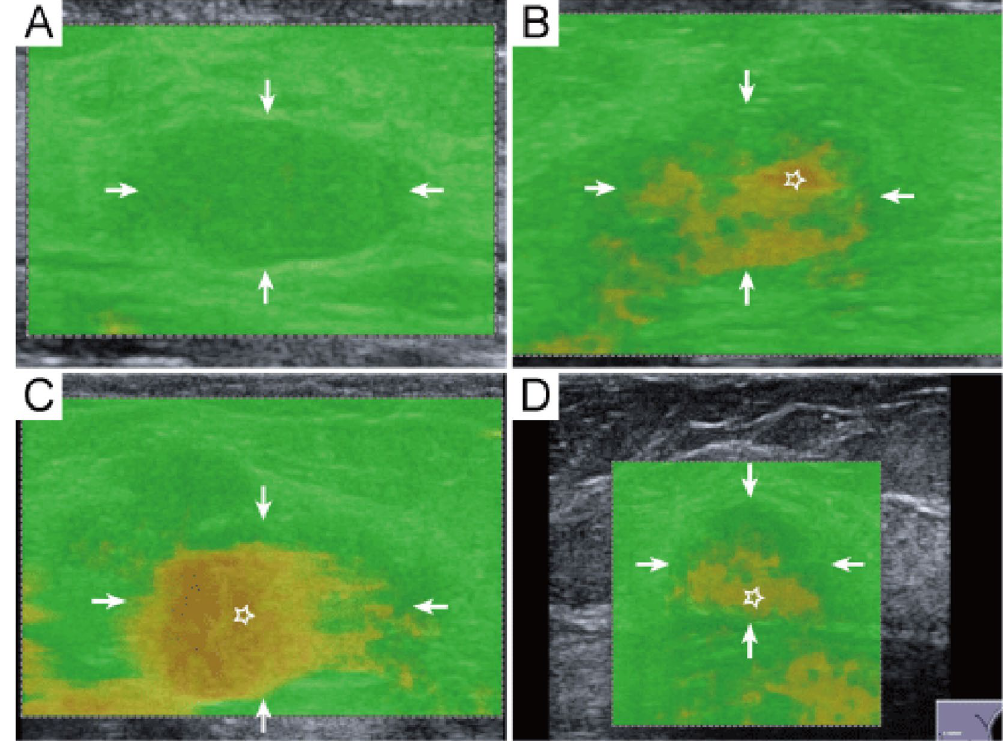
Figure 5. The evaluation standard of QM. ( A ) High QM-the whole breast lesion (arrows) is covered by green color on QM image. ( B – D ) Low QM-the lesion or surrounding rim is covered by yellow or red color (five- pointed star). QM = quality